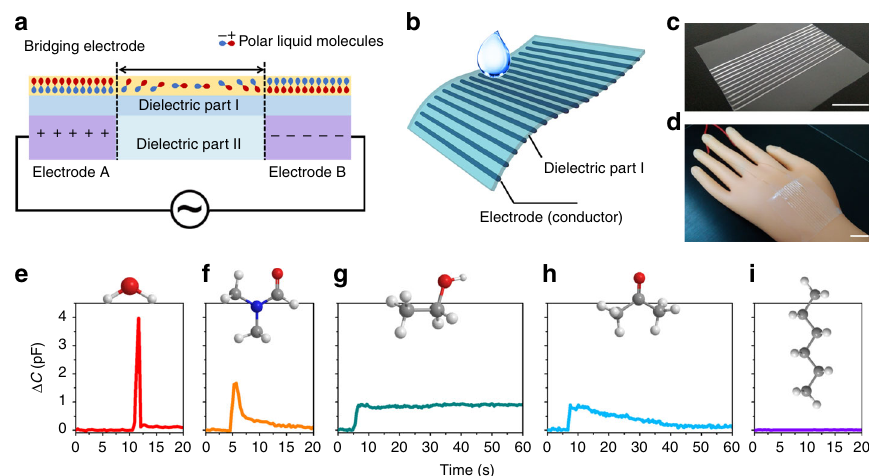
Fig. 6 Recognition of different liquid molecules. a The circuit schematic illustration of a sensory system to identify different liquid molecules. b The 3D-pringting architecture of the sensory system. c A photograph of the 3D-pringting sensory system (scale bar: 2 cm). d A photograph of the 3D-pringting sensory system attached to a robotic hand (scale bar: 2 cm). e – i Different capacitive responses when different liquids, i.e., e water, f DMF, g ethanol, h acetone, i n-hexane, drip on the robotic hand covered with the sensory